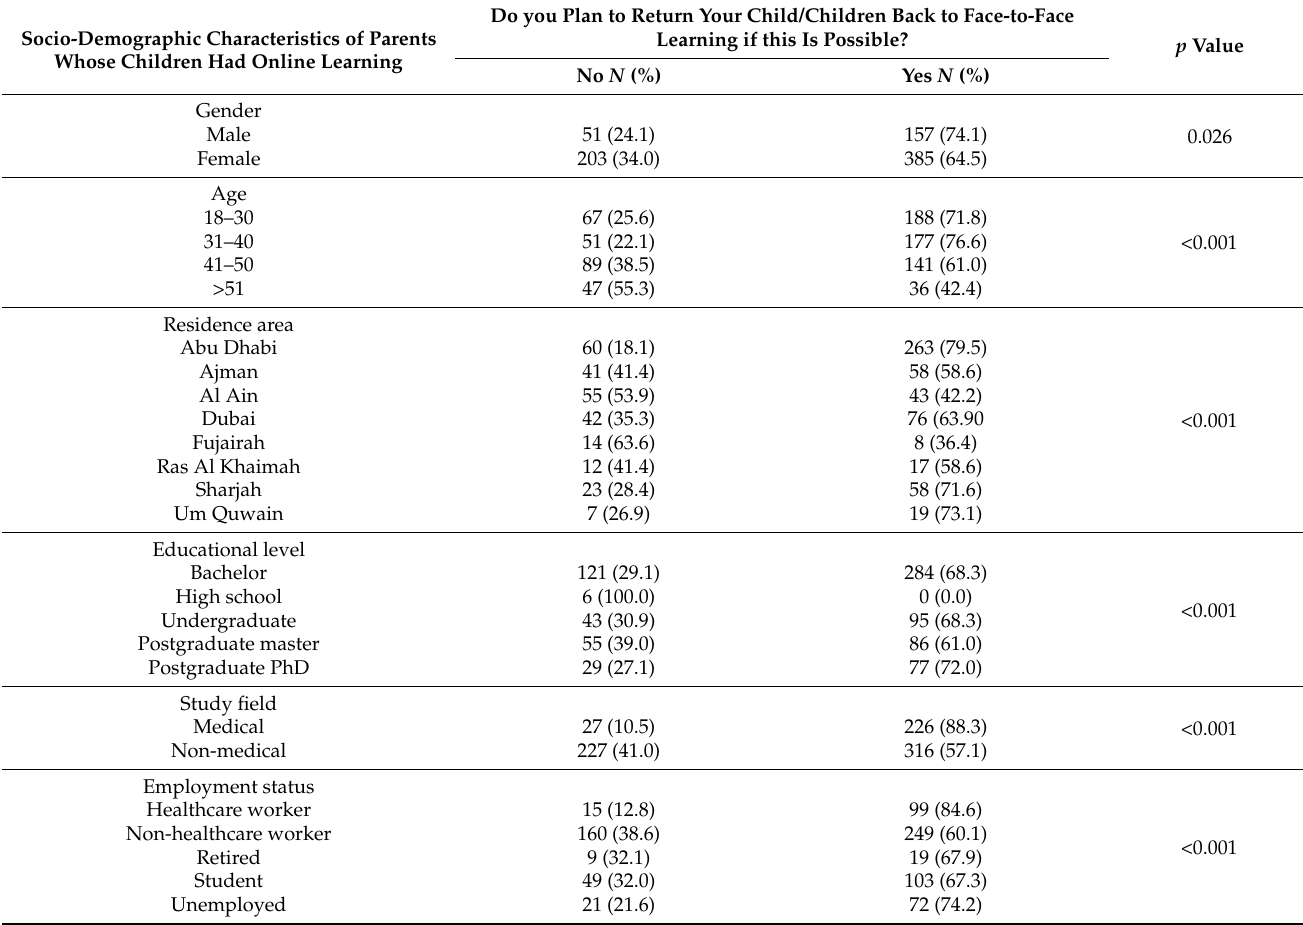
Table 5. Association between socio-demographic characteristics and parents’ willingness to get their children back to school ( n =